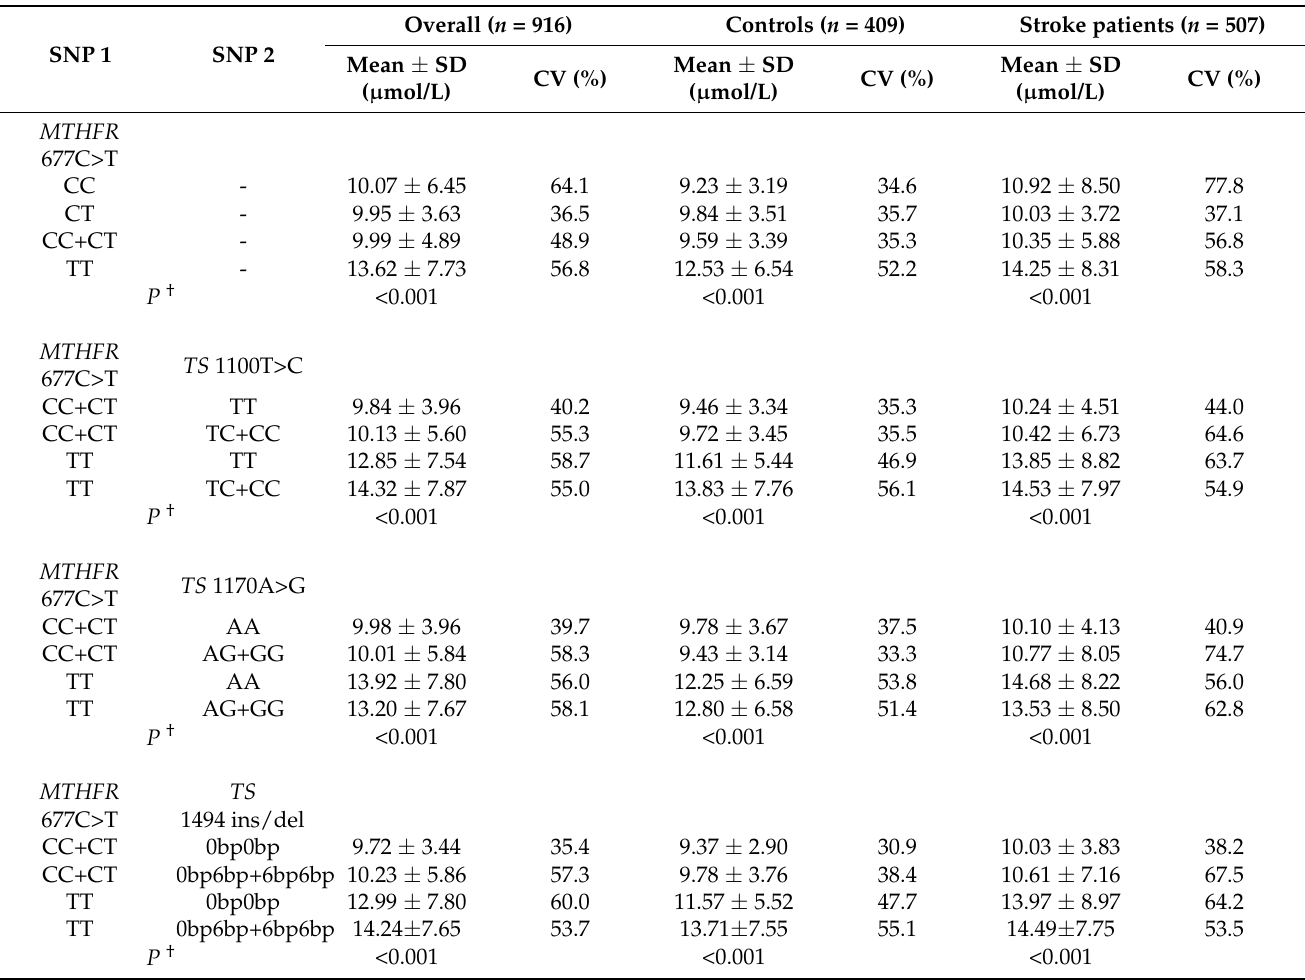
Table 4. Altered total plasma homocysteine levels based on combinations of MTHFR 677 and TS 3 (cid:48) -UTR genotypes in control patients compared to ischemic stroke